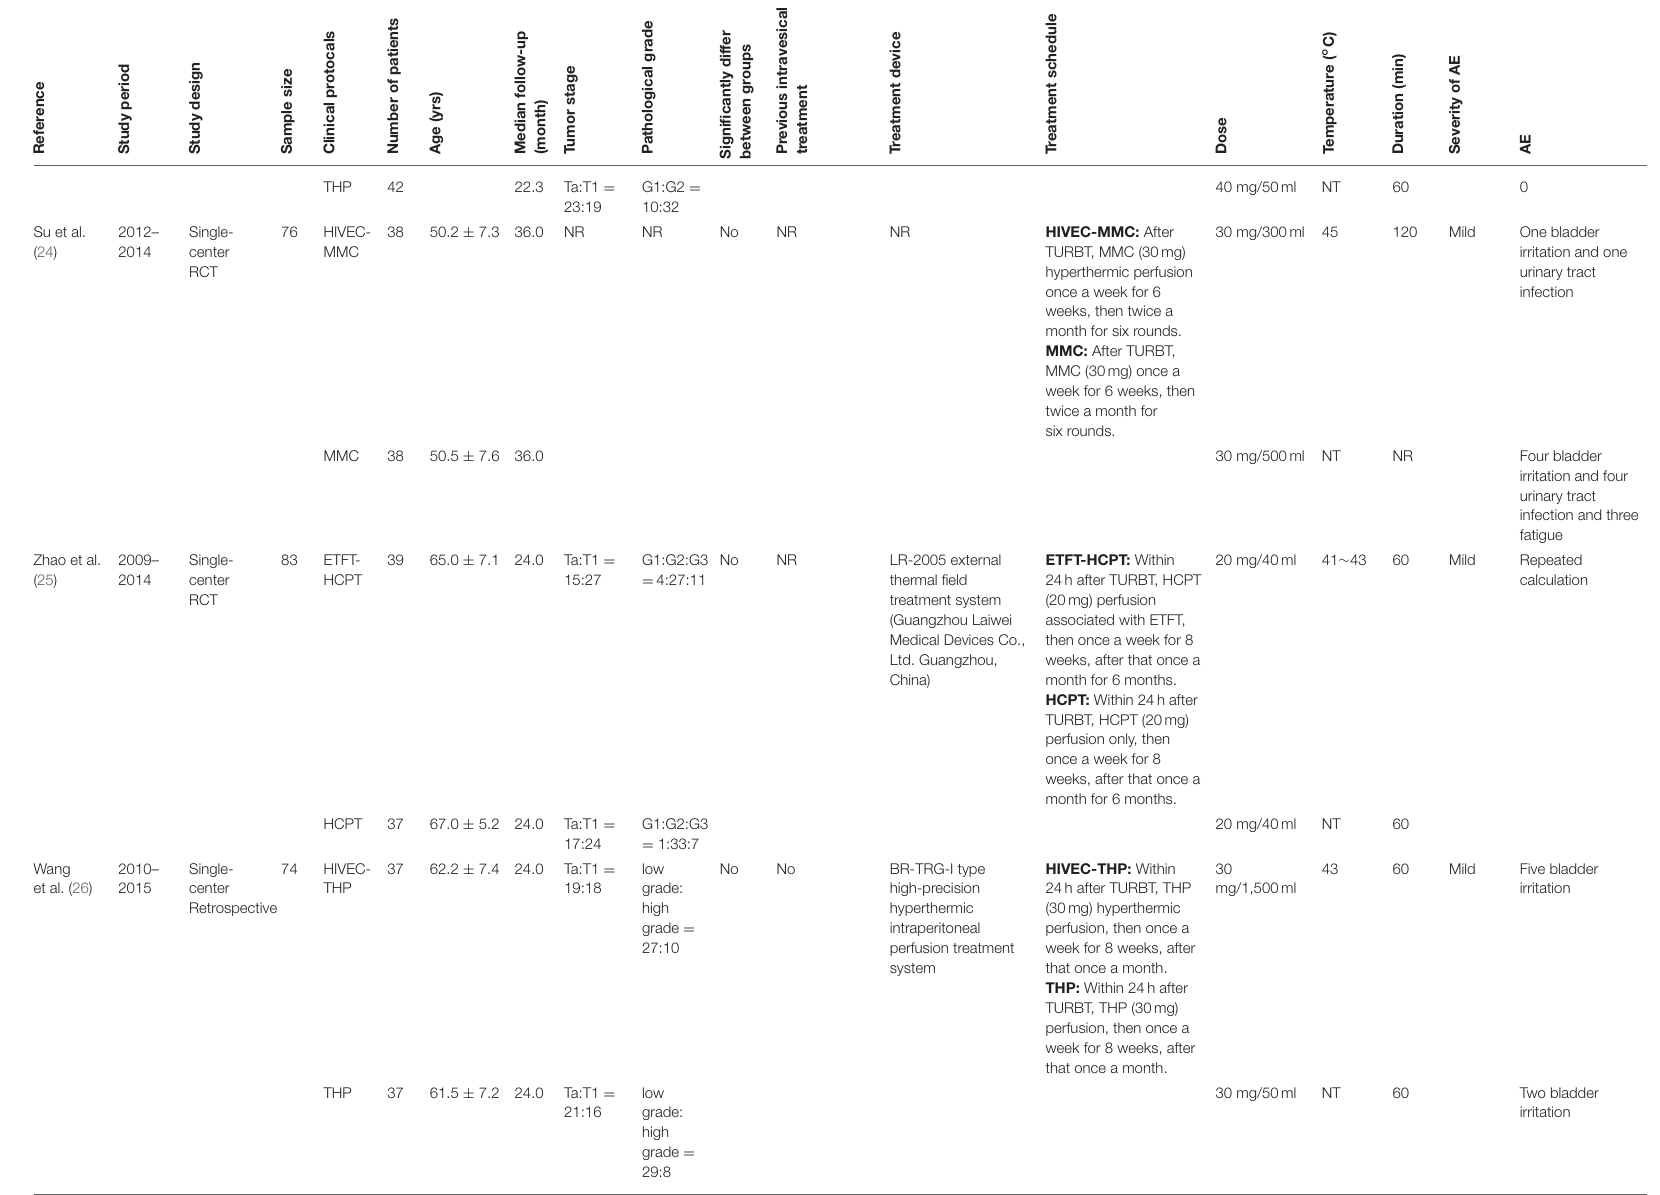
RCT, randomized controlled trial; ETFT, external thermal field thermotherapy; HIVEC, hyperthermic intravesical chemotherapy; MMC, mitomycin C; THP, pirarubicin; GEM, gemcitabine; HCPT, hydroxycamptothecine; NT, normal temperature; NR, not